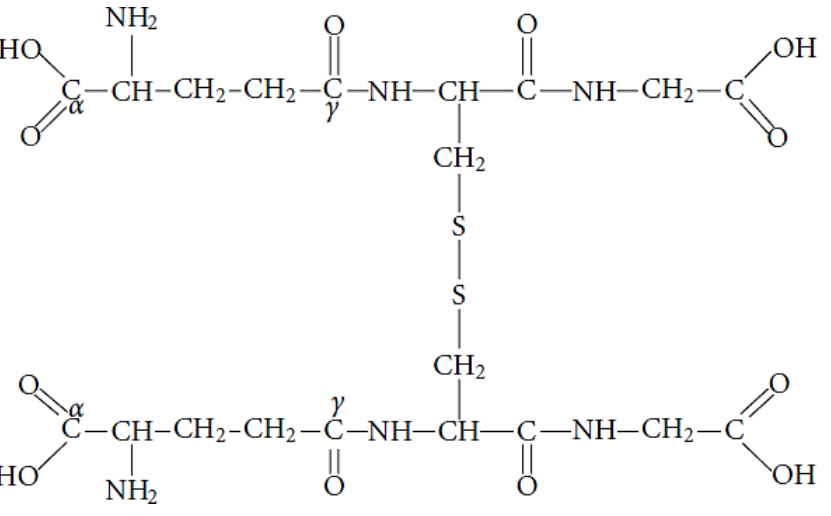
Figure 6. The oxidized form of glutathione (GSSG).